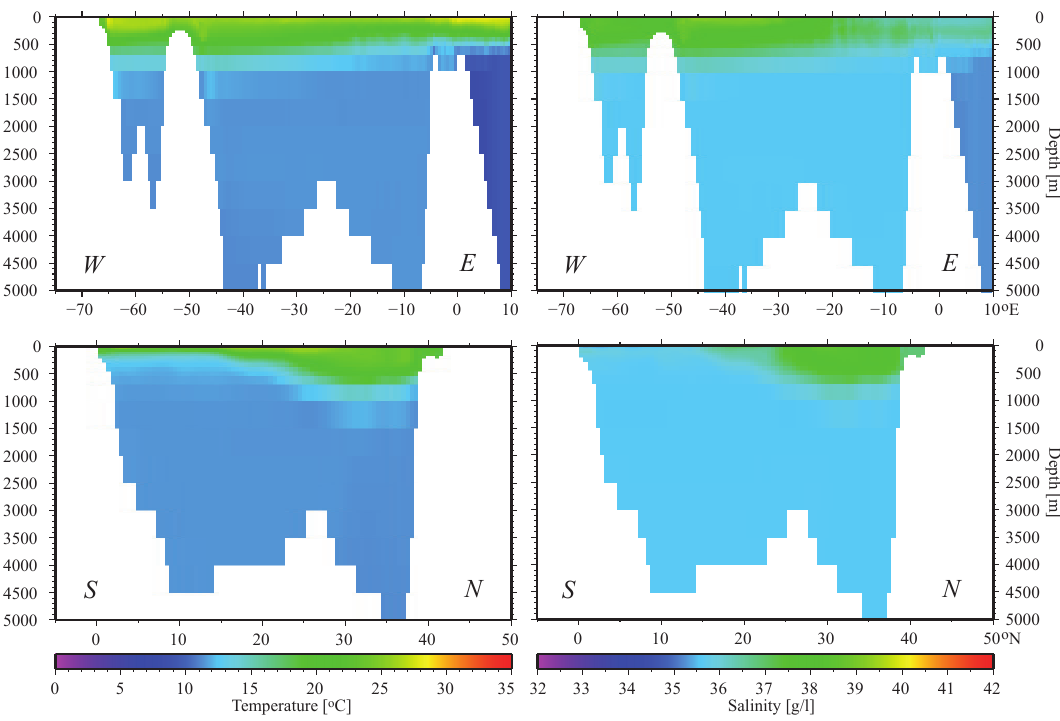
Fig. 4. REF cross sections. Two sets of cross sections of temperature (left) and salinity (right) give an overview of the tracer distribution in the vertical direction. The west-east sections are taken at 27.5 ◦ N and the south-north sections at 25 ◦ W.